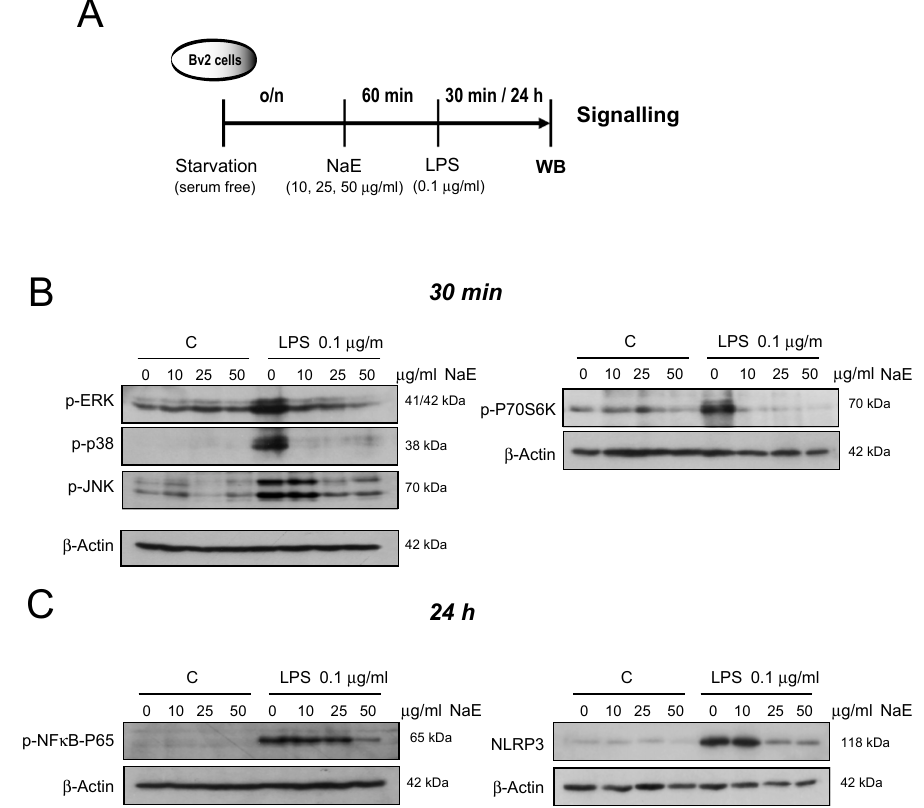
Figure 2. Effect of NaE extract on LPS-modulated signaling proteins in BV2 microglia. ( A ) Experi- mental steps. Cells were pre-treated with the indicated doses of the NaE extract for 1 h at 37 °C, and then were stimulated with or without 0.1 µg/mL of LPS for ( B ) 30 min or ( C ) 24 h. ( B ) Activation of the MAPKs family was verified using specific antibodies of phosphorylated ERK, p38, JNK and P70S6K proteins. ( C ) Expression levels of NLRP3 and phosphorylated NFkB-p65 were detected using specific antibodies. β -actin was used as the internal control. N = 4. Western blot bar graphs are in Supplementary Material Figure